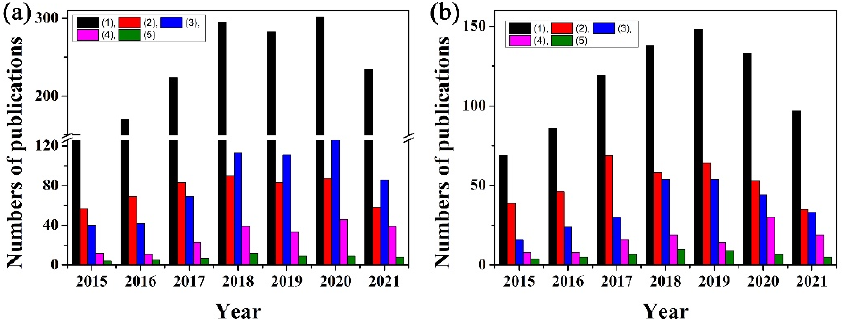
Figure 1. The annual publications numbers from 1 January 2015 to 30 October 2021 on the keywords: ( a ) (1) paper-based analytical devices and paper-based analytical devices plus (2) electrochemical, (3) colorimetric, (4) fluorescence, (5) Raman; and ( b ) (1) paper-based analytical devices